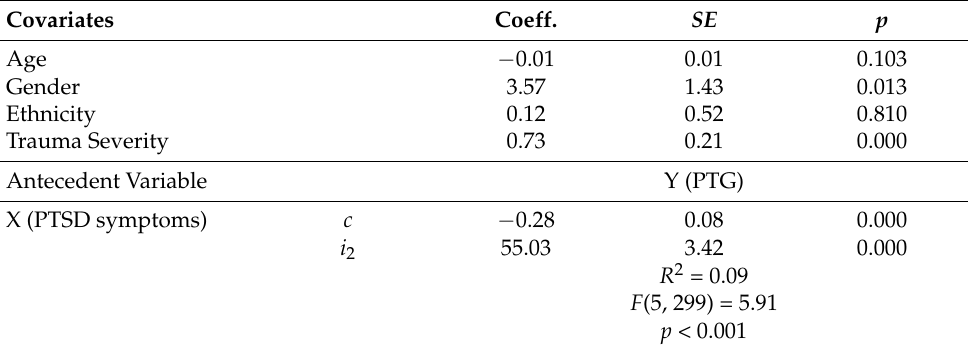
Table 3. Model coefficients for the total effect of PTSD symptoms on PTG (Path c ). Covariates Coeff. SE p